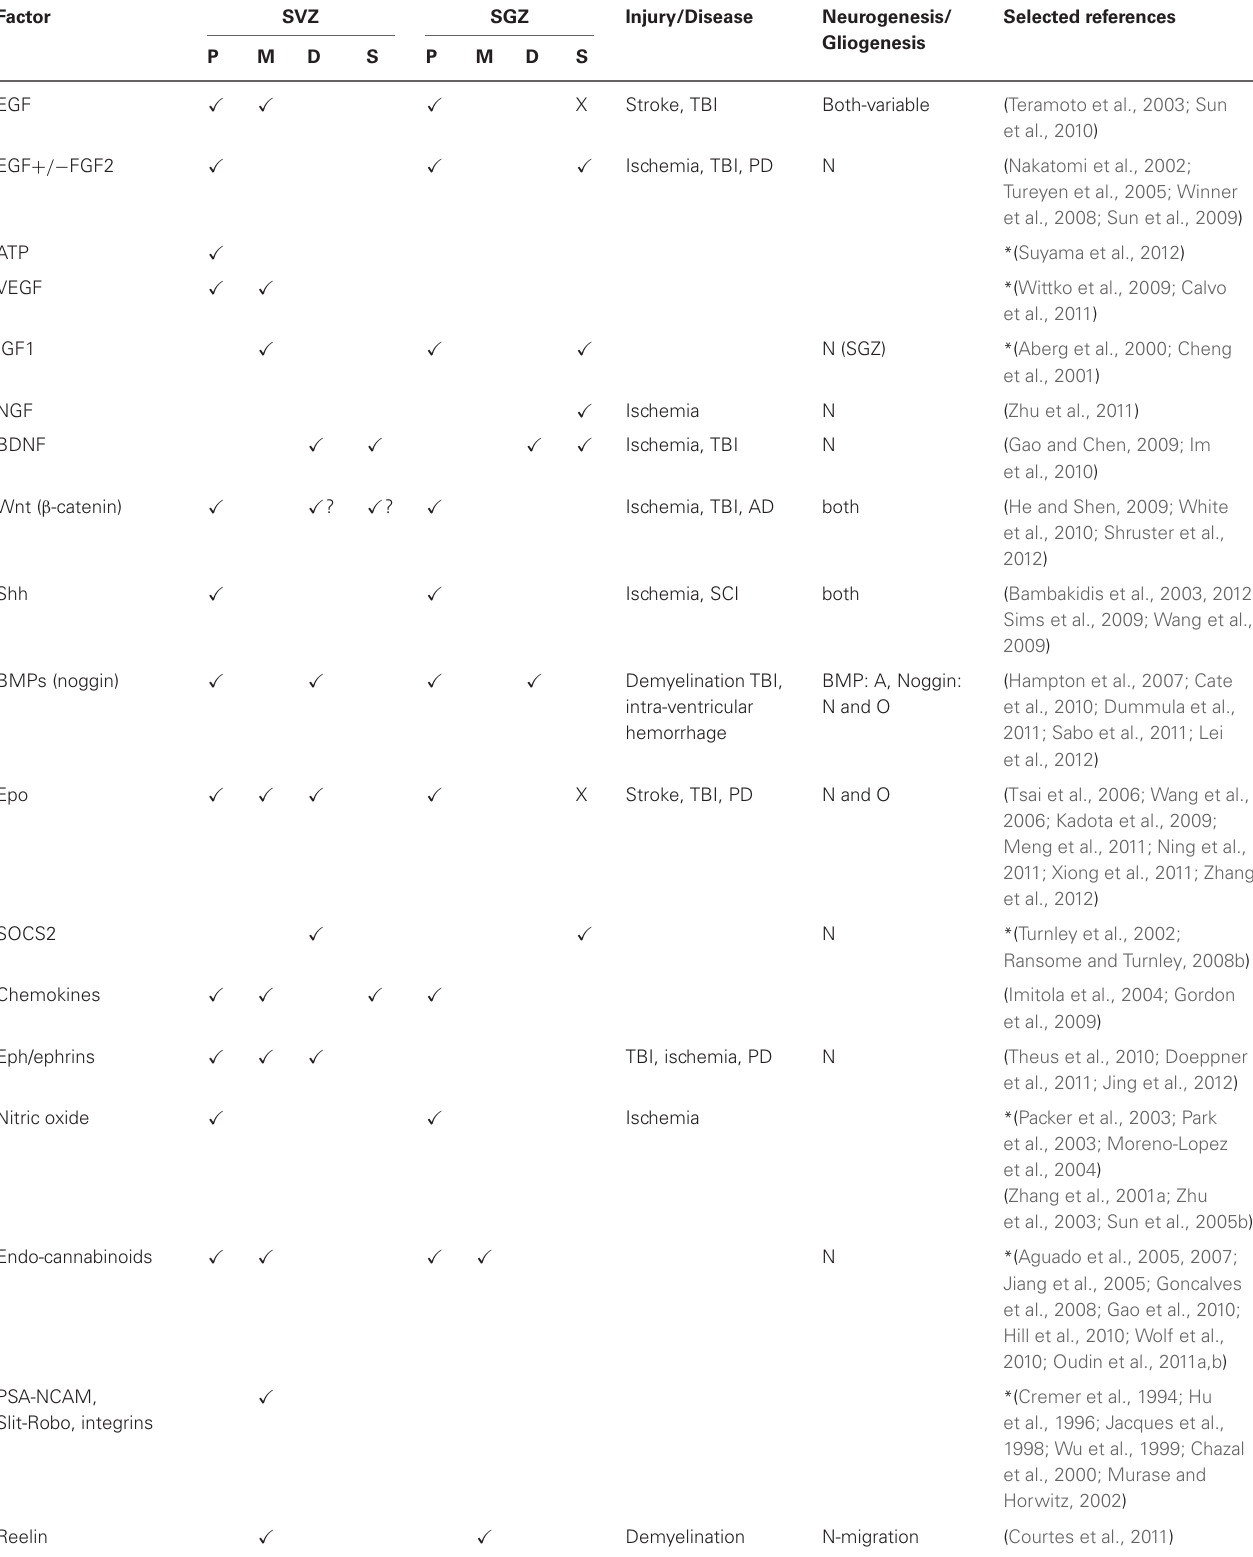
Table 1 | Extrinsic factors affecting SVZ and SGZ NSPC responses under basal conditions and following neural damage.